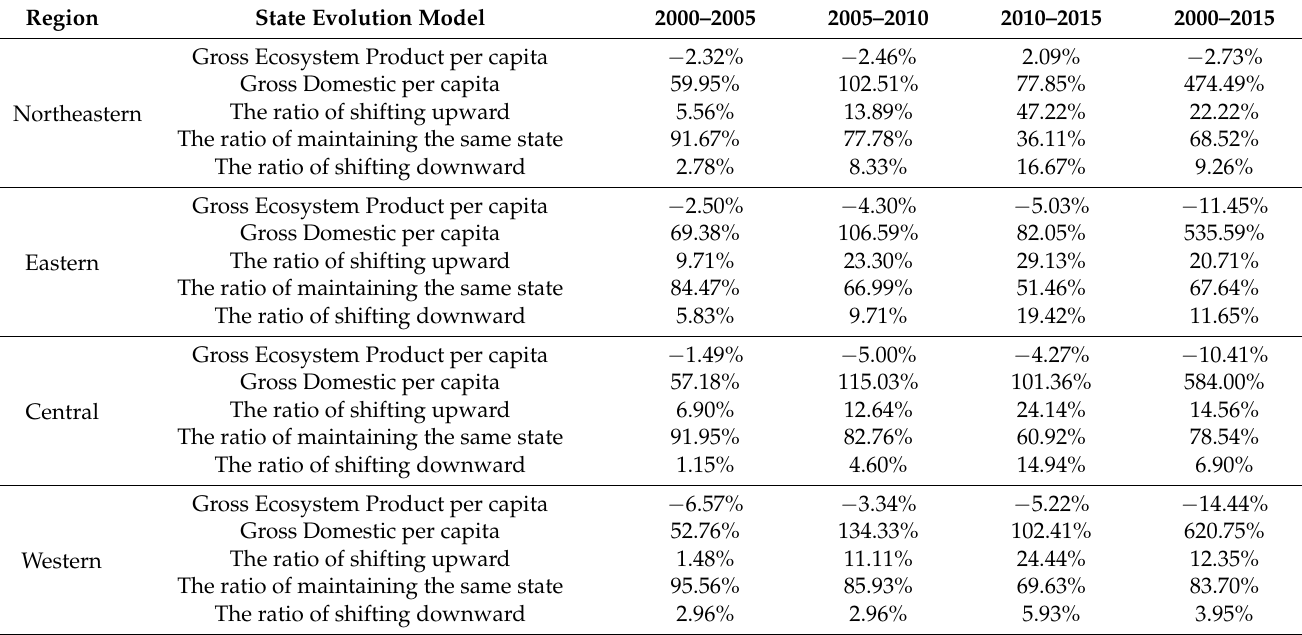
Table 4. Regional contribution of the evolution of the GEP–GDP synergistic states in the Chinese mainland by investigation